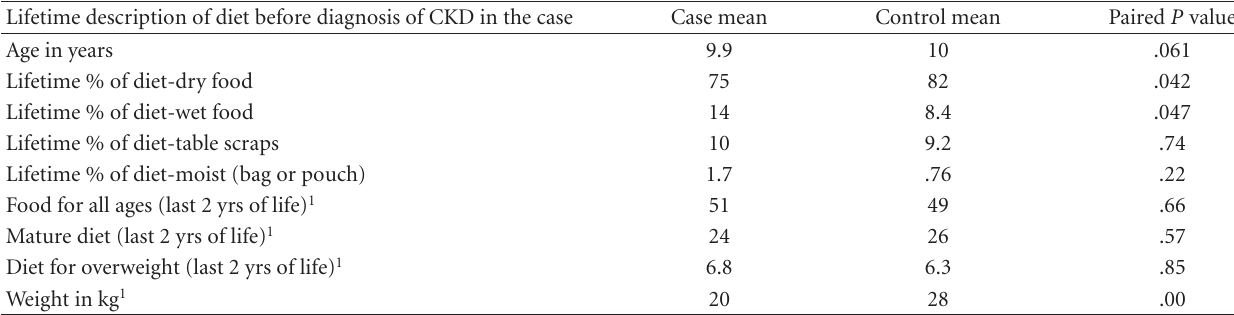
Table 6: Canine-analysis of continuous variables regarding observations before the diagnosis of CKD in the case, analyzed by matched t -test. Lifetime description of diet before diagnosis of CKD in the